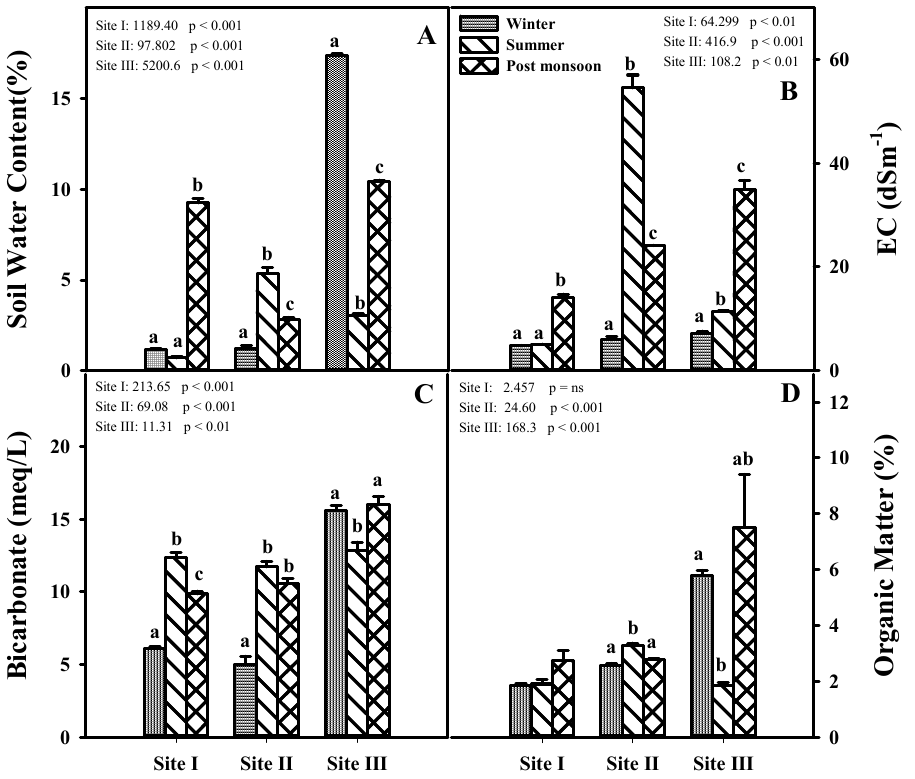
Figure 2. Water content ( A ), Electrical conductivity ( B ), Bicarbonates ( C ) and Organic matter ( D ) in soil of test species at Sandspit (Site I), Clifton (Site II) and Korangi (Site III). Different letters on error bars indicate significant differences among seasons on the same site ( n = 3) at p ≤ 0.05.